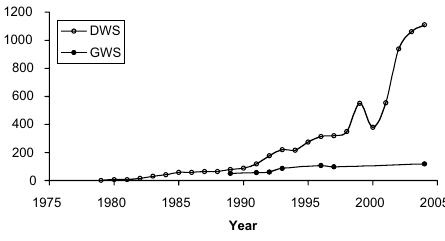
Fig. 4. Maximum numbers of grey seals counted in the Dutch (DWS) and German (GWS) Wadden Sea, from1979 through 2004. The mean annual rate of increase in Dutch part was 19% (based on spring counts), and in Germany 6% (based on summer